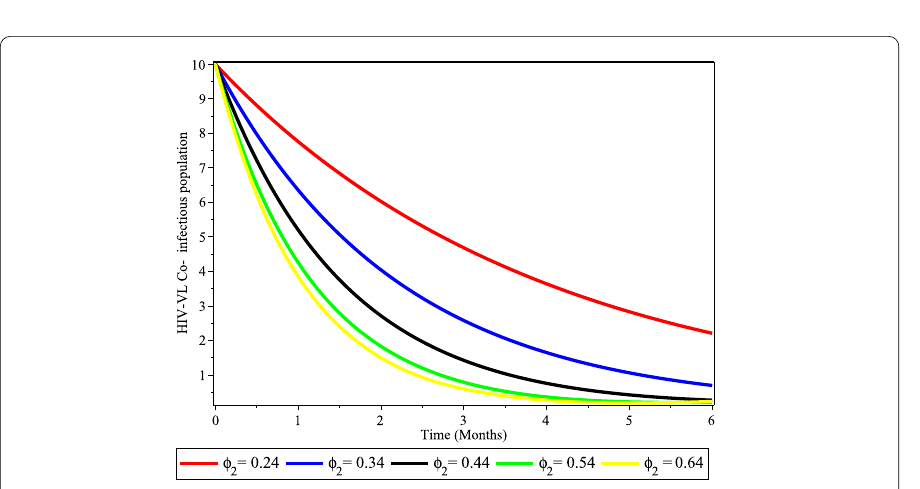
Figure 5 Effect of VL progression rate on the sand fly